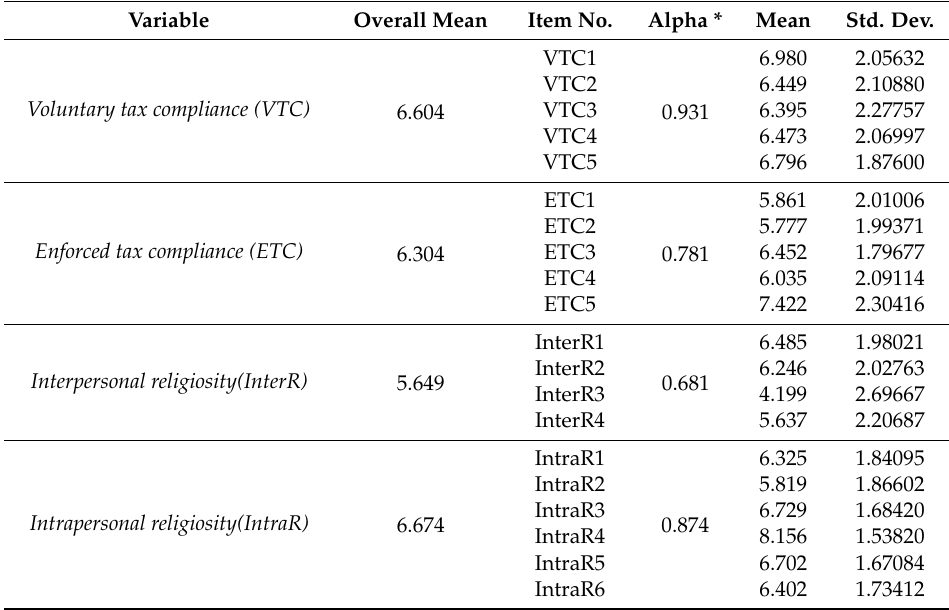
Table 2. Descriptive statistics and reliability